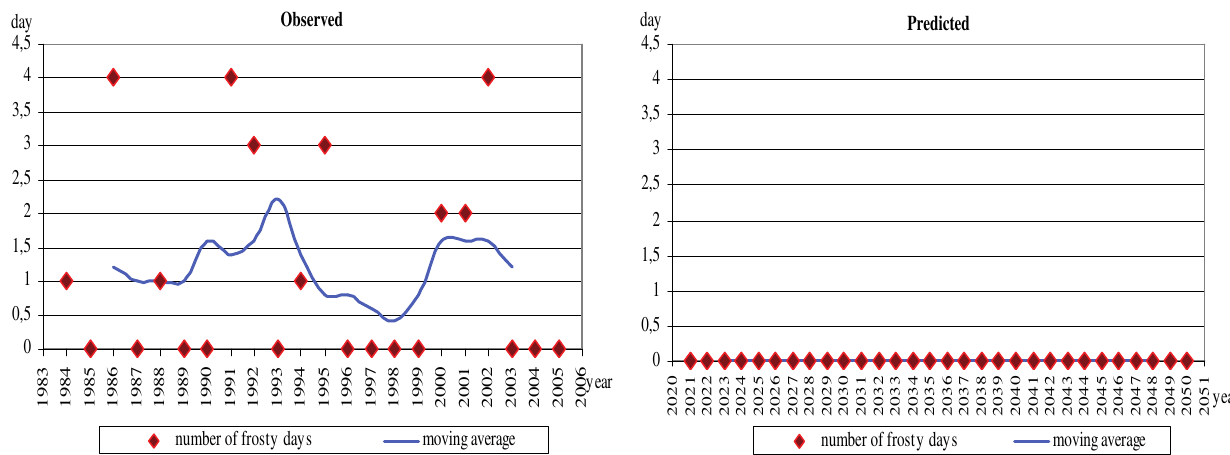
Figure 1: Number of frosty days at Újfehértó on the basis of historical data and of RegCM 3.1 data for the 10-day long period before bloom and during the blooming period